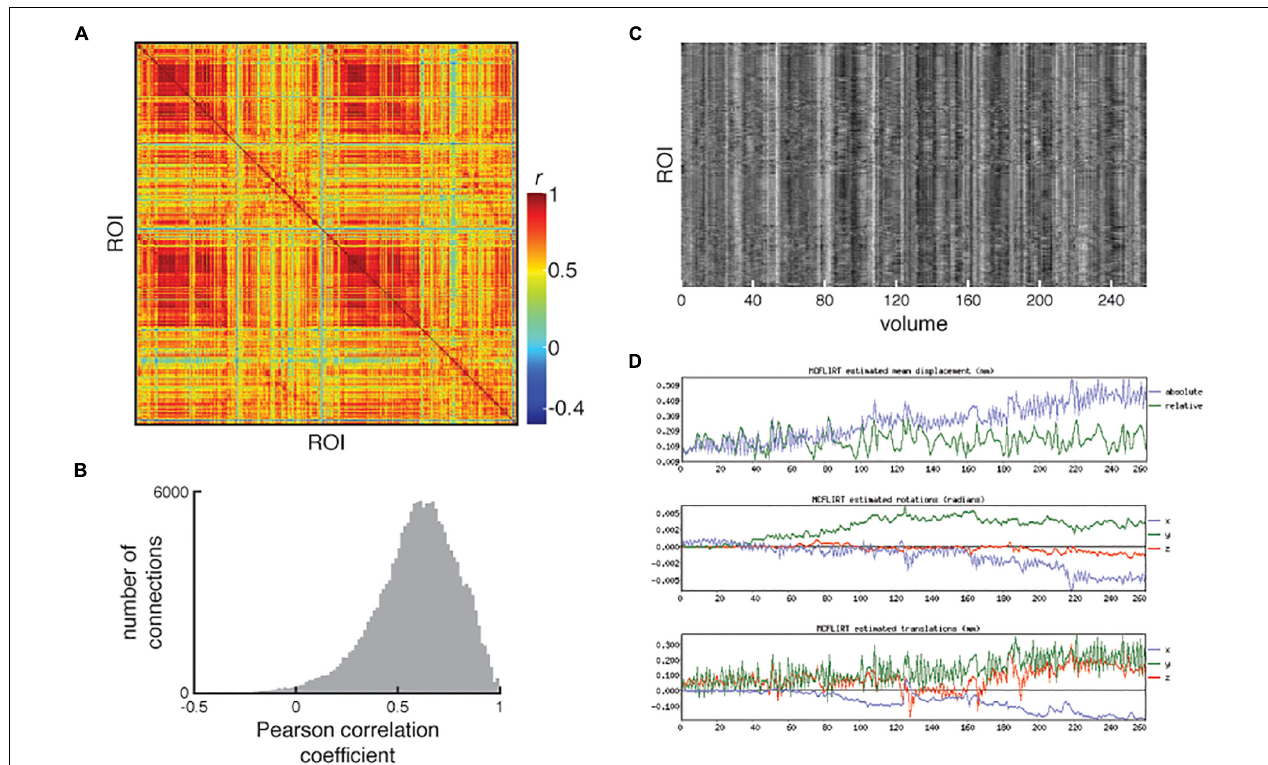
FIGURE 8 | An example of poorly processed resting-state fMRI. (A) Functional connectivity matrix and (B) distribution of functional connectivity show large number of strong positive correlations and a compressed range of correlations. (C) Examination of the carpet plot of region of interest (ROI) time series suggests artifacts remain in fMRI data after cleaning. (D) In the QC report, motion estimations from MCFLIRT are shown alongside the carpet plots for quick assessment. All images reproduced from the example subject’s QC